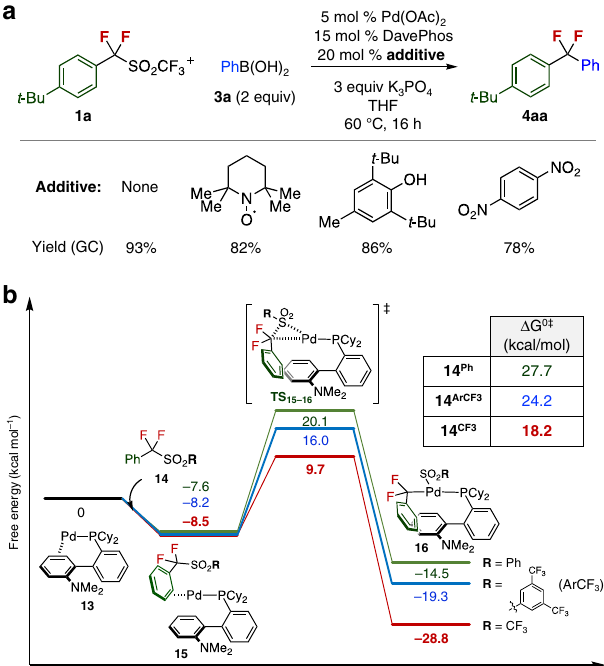
Fig. 5 Mechanistic studies of desulfonylative Suzuki − Miyaura cross-coupling reaction. a The effect of radical and electron-transfer inhibitors. b The energy pro fi le at C – SO 2 bond activation step by theoretical calculation. All structures were optimized with B3LYP functional using the LANL2DZ basis set for Pd and the 6 – 31G(d) basis sets for other atoms. By using the optimized geometries, we performed thermal correction at (333.15K) and single point calculations with SCS-MP2 to obtain Gibbs free energy. The solvation effect was computed with SMD (1,4-dioxane)